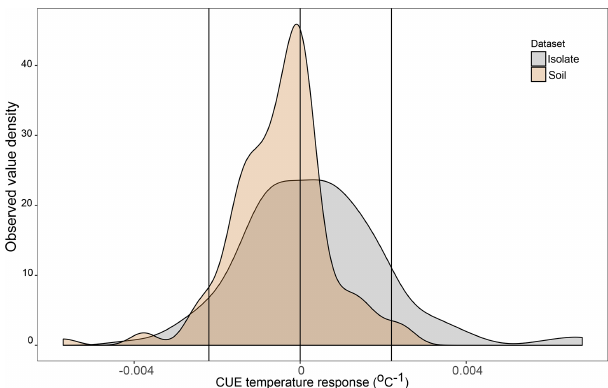
Figure 2. Density plot of the observed CUE temperature response for 23 soil bacterial isolates grown between 15 and 25 ◦ C on four different liquid media types in the lab ( n = 160 datapoints, grey) and for soil microbial communities grown with various different substrates and temperatures based on a literature search ( n = 141 datapoints, brown). Vertical lines are placed at 0 (no change in CUE with temperature) as well as the ± 0 . 022 ◦ C − 1 upper and lower limits used in the present study. Contributing datapoints are pri- marily derived from Qiao et al. (2019) and can be found in the Ct_literatureValues.txt file in OSF.